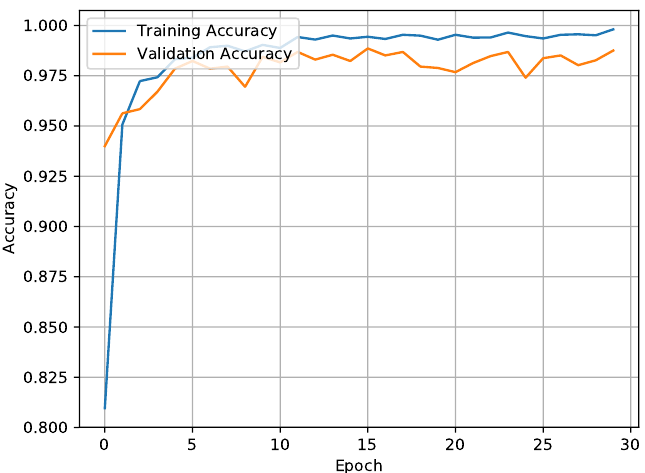
Figure 6. Training accuracy vs. validation accuracy.